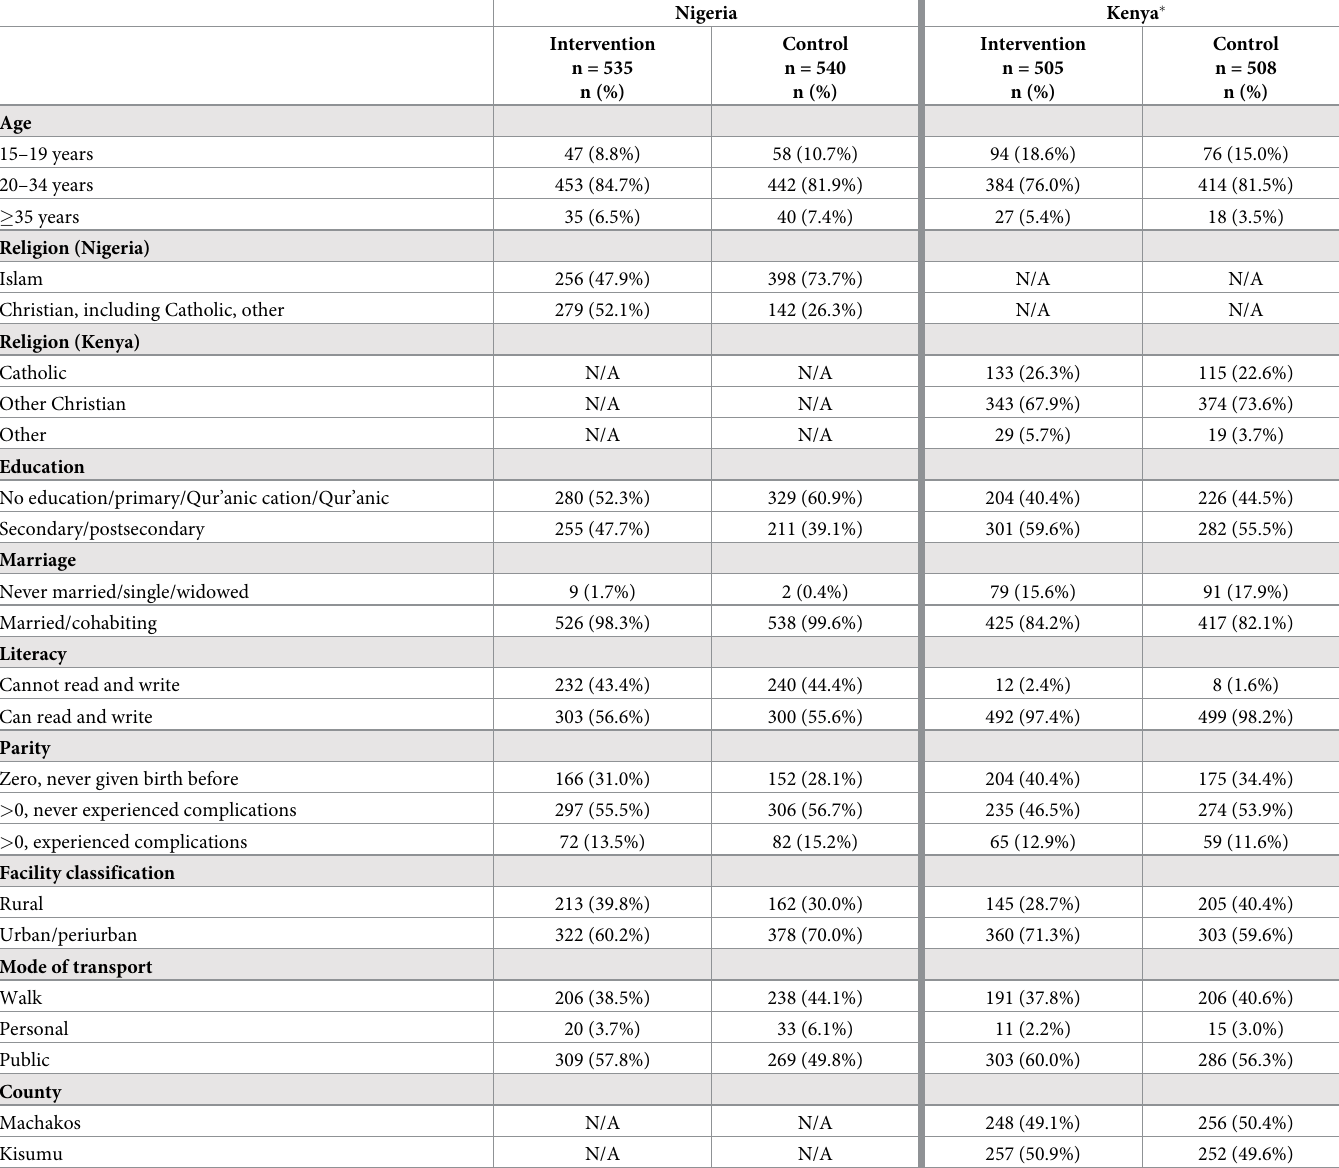
Table 1. Demographic characteristics of enrolled women at